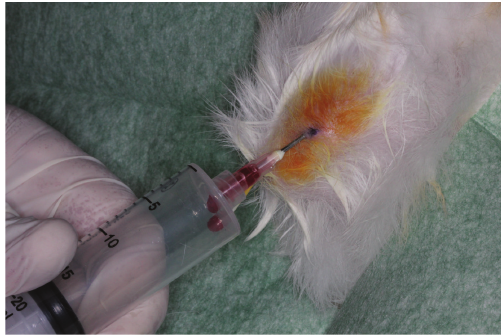
Figure 4: Autologous bone marrow being aspirated from the shin- bone of one rabbit.